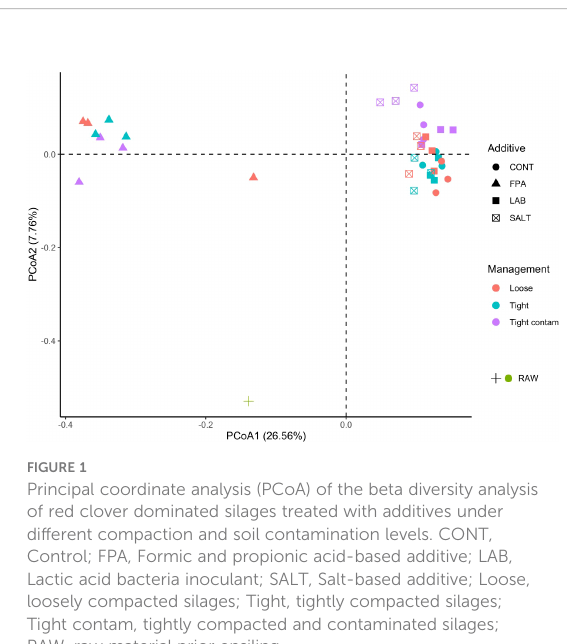
FIGURE 1 Principal coordinate analysis (PCoA) of the beta diversity analysis of red clover dominated silages treated with additives under different compaction and soil contamination levels. CONT, Control; FPA, Formic and propionic acid-based additive; LAB, Lactic acid bacteria inoculant; SALT, Salt-based additive; Loose, loosely compacted silages; Tight, tightly compacted silages; Tight contam, tightly compacted and contaminated silages; RAW, raw material prior